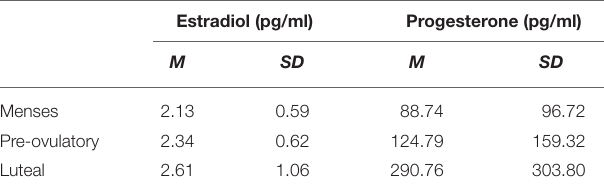
TABLE 1 | Mean levels of salivary estradiol and progesterone in each cycle phase. Estradiol (pg/ml) Progesterone (pg/ml)